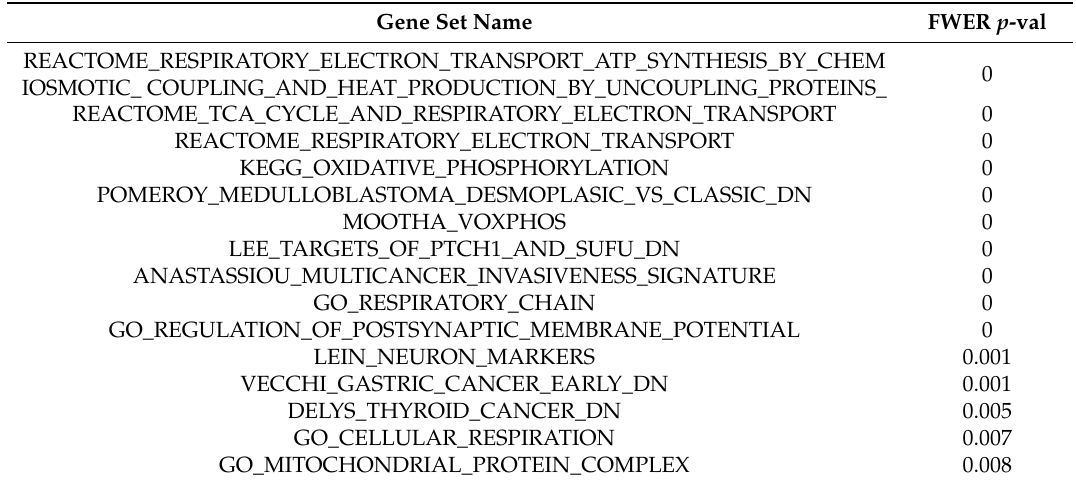
Table 2. Top Gene Set Enrichment Analysis (GSEA) categories for genes upregulated in human but not mouse SHH-MB (FWER—family-wise error rate).